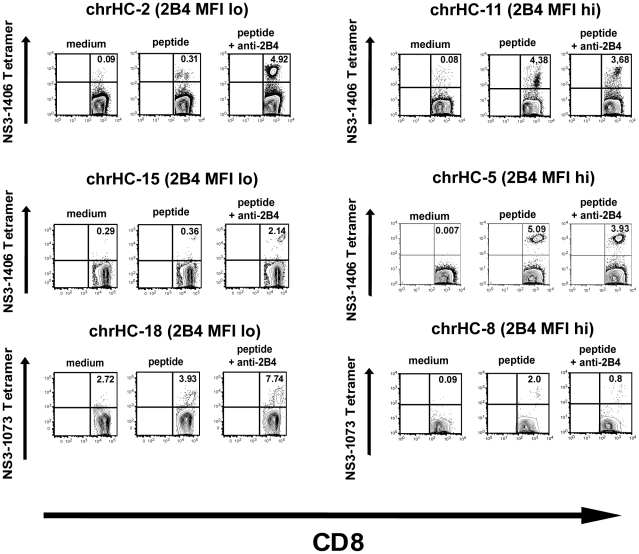
Effect of peptide stimulation and simultaneous 2B4 cross-linking on
the expansion of HCV-specific CD8+ T cells in patients with chronic
hepatitis C.Exemplary FACS plots from six different day10 cell lines analyzed are
shown, frequency of HCV-tetramer+ cells of total CD8+ T cells
are indicated. Samples were divided according to the direct ex
vivo expression intensity (MFI) of 2B4 on HCV-specific
CD8+ T cells into 2B4 MFI low (left panel) and 2B4 MFI high (right
panel). Cross-linking of 2B4 resulted in an increased frequency of
HCV-specific CD8+ T cells in those samples with low 2B4 expression
ex vivo, while for those samples with high
expression no increase or even a decrease of proliferation was
observed.